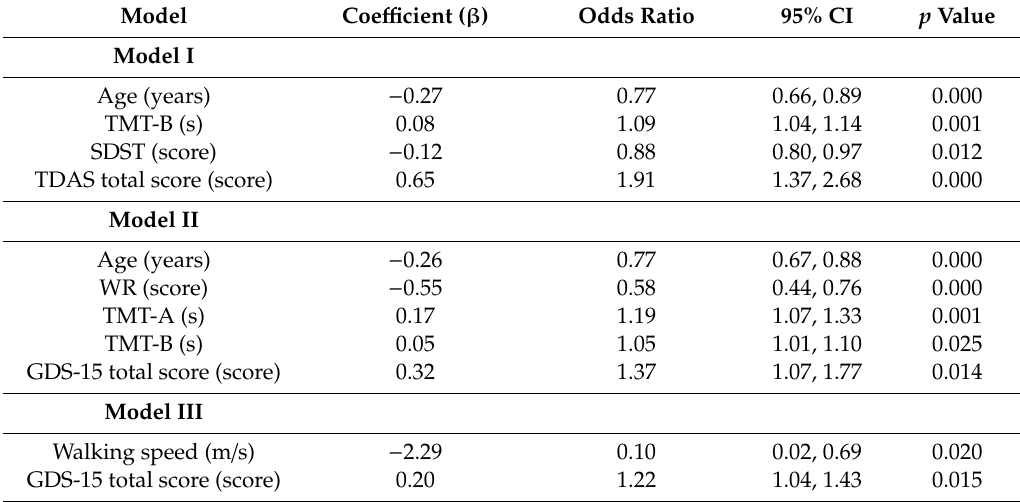
Table 3. Multiple comparison among binomial logistic regression models depending on MCI classification with odds